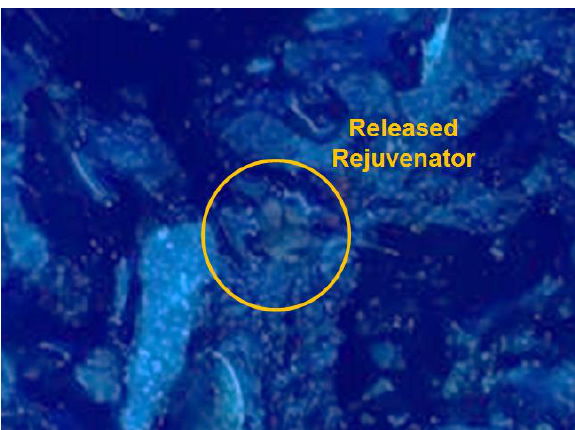
Figure 10. Released rejuvenator on fracture face.